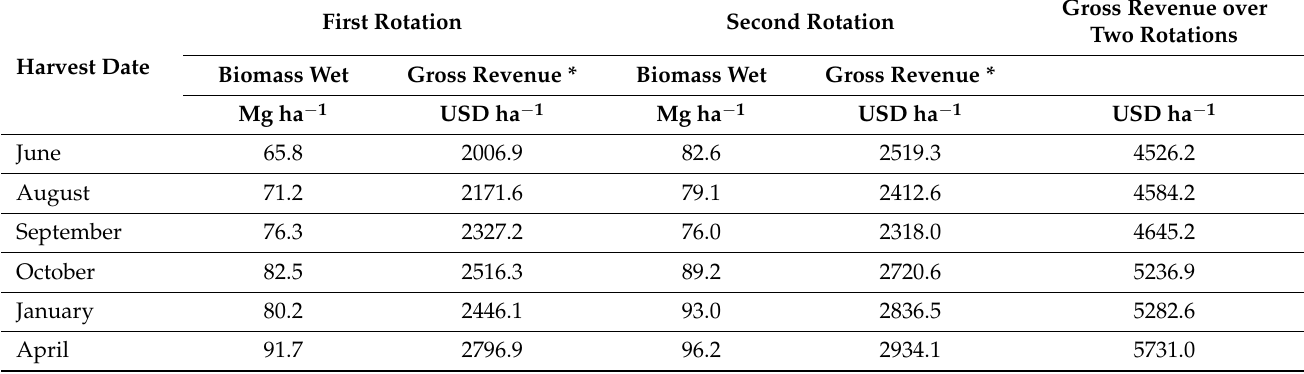
Table 6. Gross revenue from willow biomass depending on total biomass production for each harvest date. Price of biomass at gate is considered at USD 30.5/Mg using the EcoWillow 2.0 Cash Flow Model [52]. No additional costs or incomes are